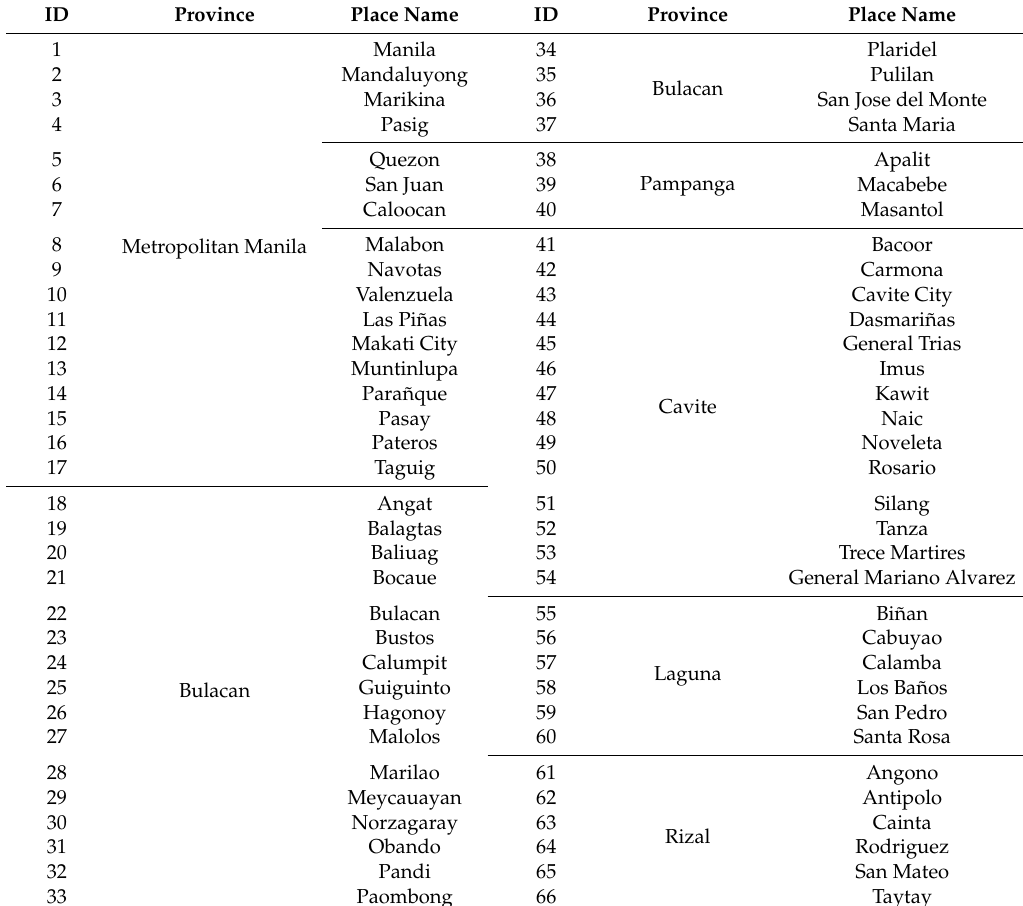
Table A1. List of place name in Manila metropolitan